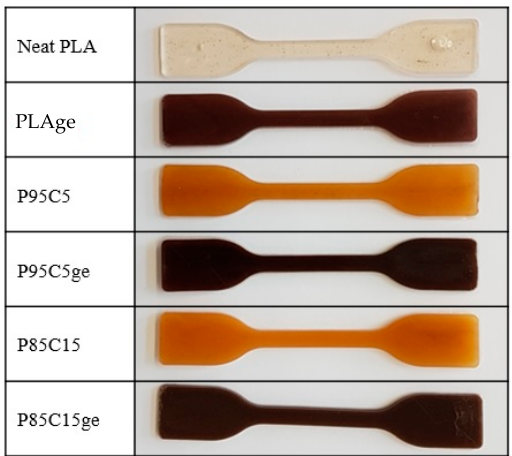
Figure 4. Photograph of the injection-molded test specimens prepared in this study. Table 4. Color measurements values of neat PLA and the